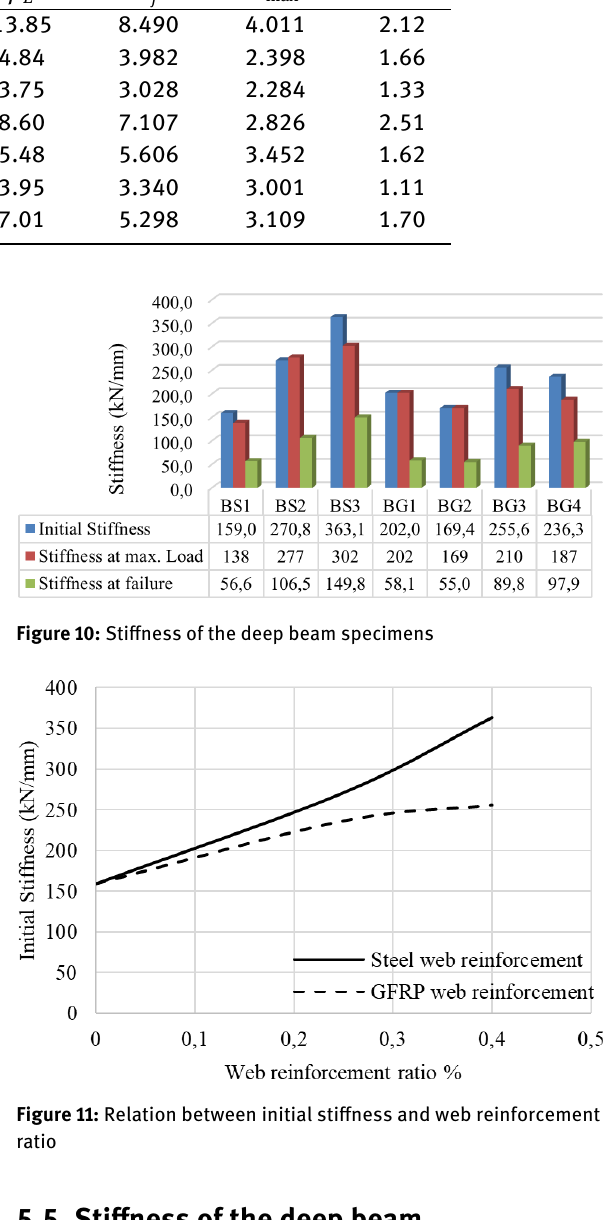
and elastic deformation and the rupture mechanics of crack propagation and initiation. The relation between web rein- forcement ratio, deformability factor, and ductility index is illustrated in Figures 7-9 and Table 5.